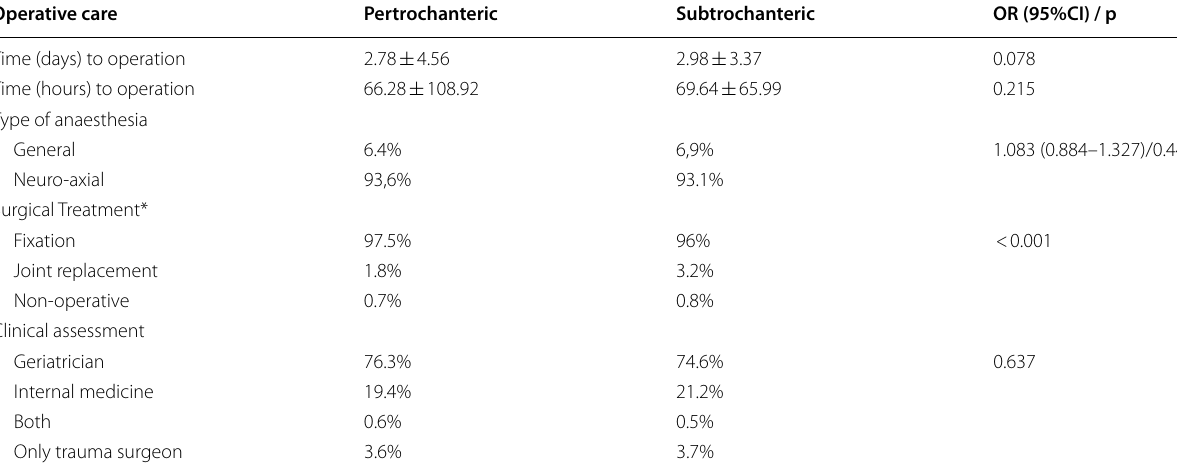
standard deviation and percentages ±